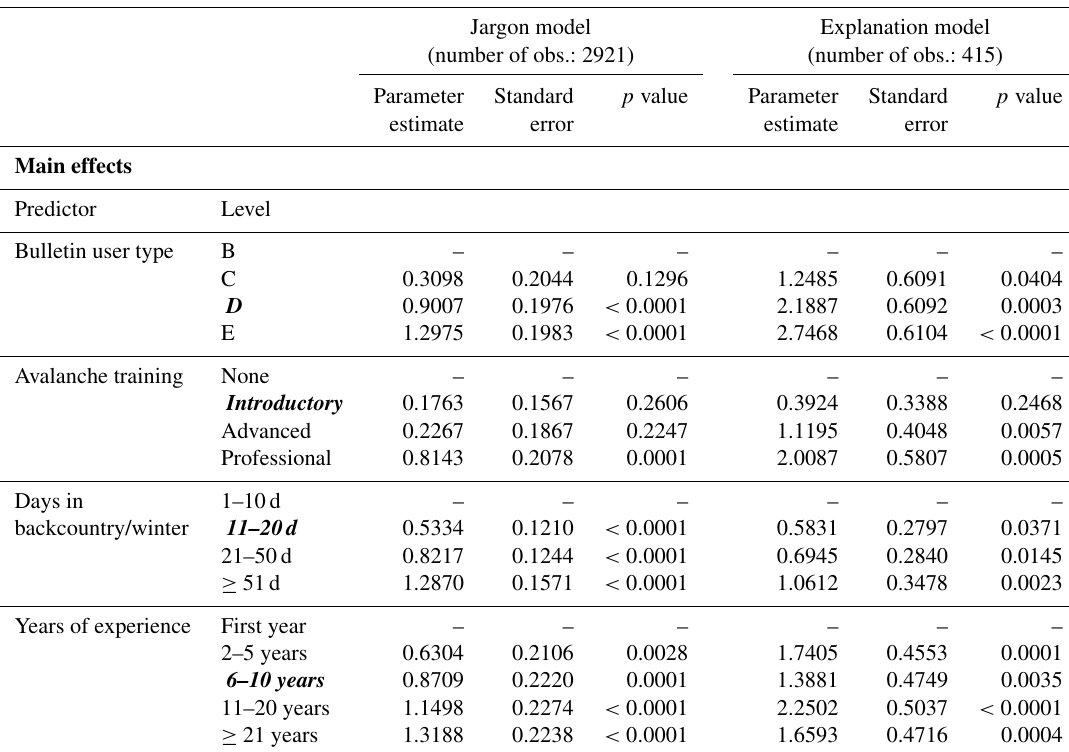
Table B4. Parameter estimates of the jargon and explanation models examining participants’ confidence in recognizing the highlighted feature in the TTA statements. Bolded and italicized levels are used for calculating the estimated marginal probabilities for the post hoc